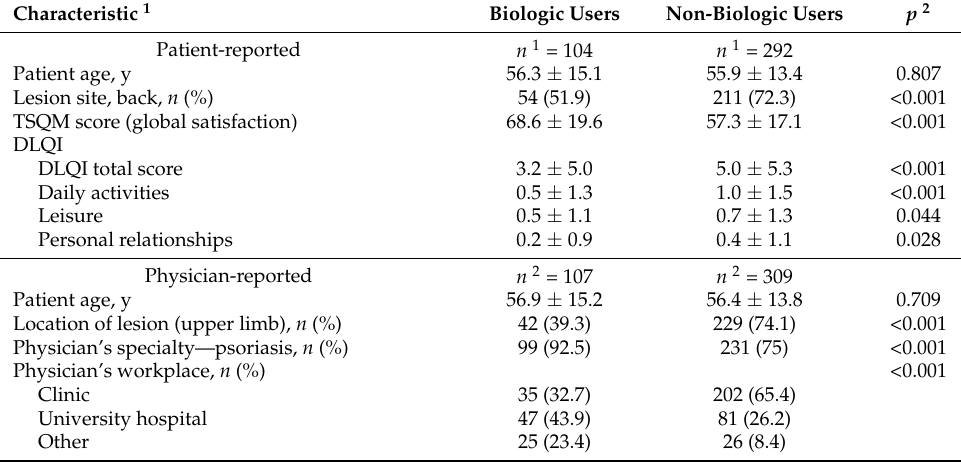
Table 3. Comparison of patient- and physician-reported characteristics between biologic users and non-biologic